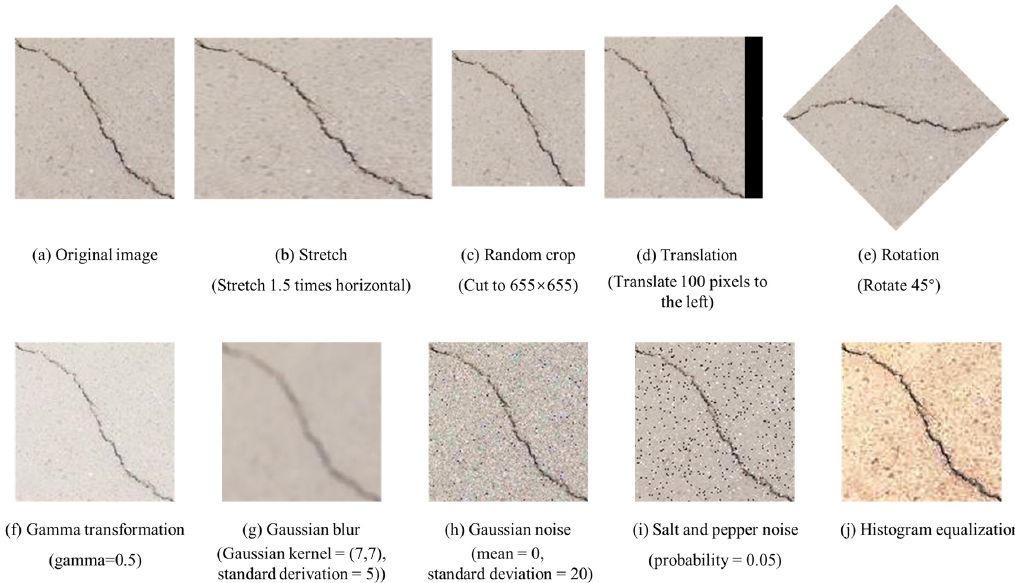
Figure 3. Nine different types of data augmentation methods. ( a ) Original image; ( b – e ) Four geometric transformations; ( f – j ) five photometric transformations.